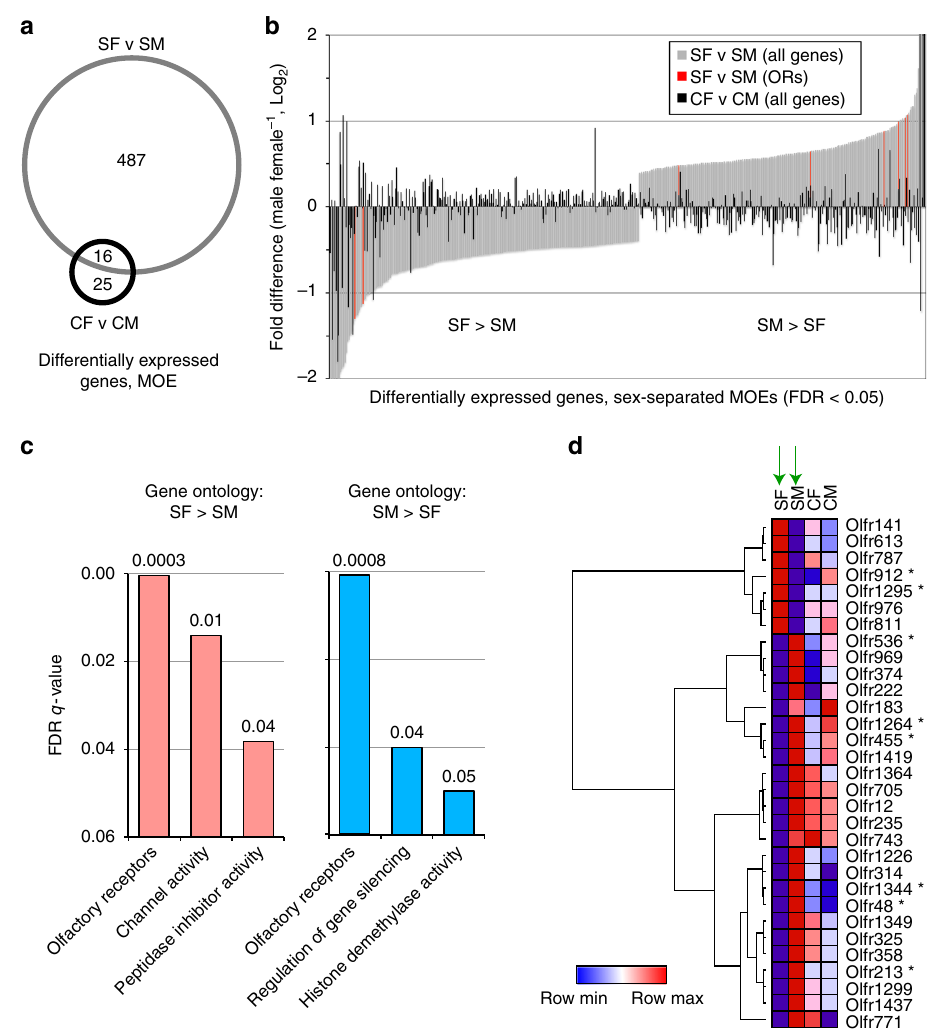
Fig. 2 Sex separation induces sex-speci fi c differences in the expression of genes, including ORs, in the MOE. a Venn diagram of expressed genes identi fi ed via RNA-seq as signi fi cantly differentially expressed (FDR < 0.05) within the MOE between male and female sex-separated (SF versus SM) and sex combined (CF versus CM) mice. b Comparison of the differential expression of individual genes within the MOE between SF and SM mice (gray) or between SF and CM mice (black). Shown are genes identi fi ed via RNA-seq as signi fi cantly differentially expressed (FDR < 0.05) in the MOE between SF and SM mice. Genes encoding odorant receptors (ORs) are highlighted in red. c Enriched gene ontology (GO) categories among genes identi fi ed by RNA- seq as signi fi cantly differentially expressed (FDR < 0.05) in the MOE between SF and SM mice. Shown are analyses of female-biased (SF > SM; left) and male-biased (SM > SF; right) genes. d Hierarchical clustering of OR-encoding genes identi fi ed via RNA-seq as signi fi cantly differentially expressed between SF and SM mice (green arrows). ORs labeled asterisk, FDR < 0.05; other ORs shown, unadjusted p < 0.01 (Cuf fl inks output). SF sex-separated females,